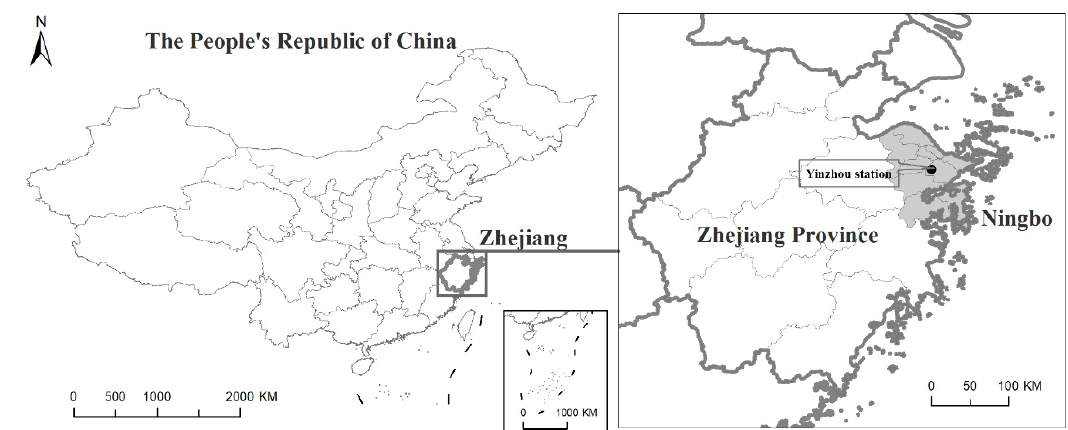
Figure 1. The geographical location of Ningbo and Yinzhou station.